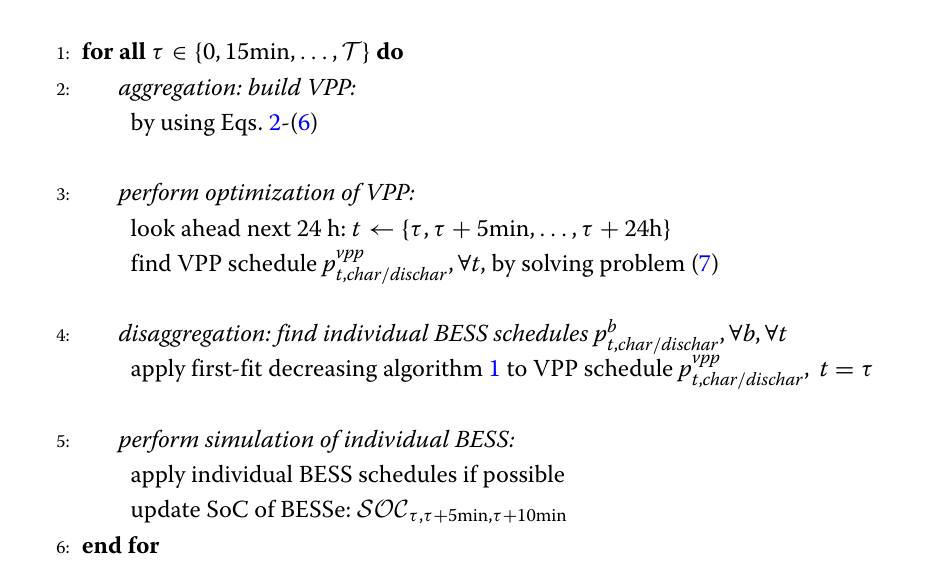
Algorithm 3 Procedure of co-simulation framework: based on aggregated optimization problem (7) and first-fit decreasing algorithm